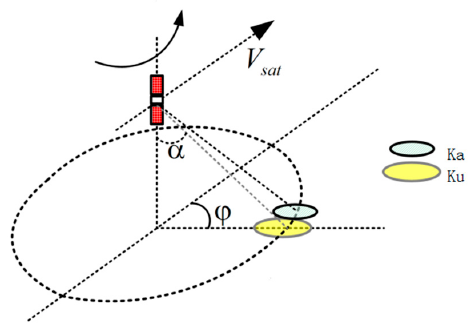
Figure 7. Dual-frequency Doppler scatterometer (DfDopScat) scanning geometry.